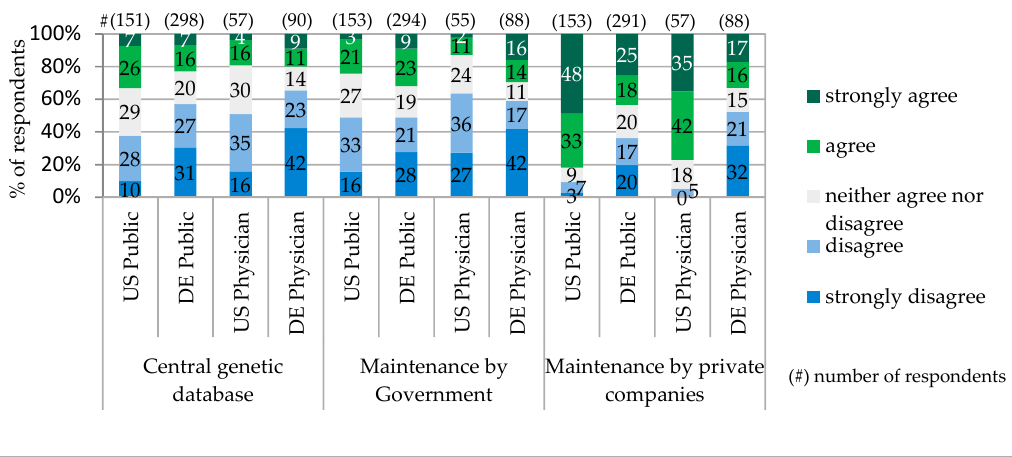
Figure 5. Genetic Database Models.